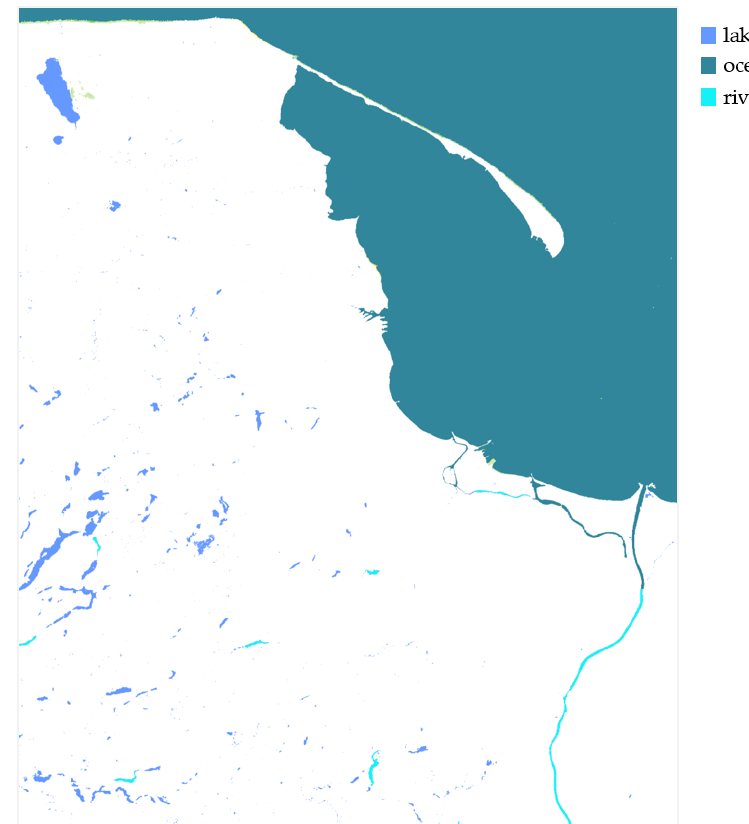
Figure 5. Example of the classification around Gdansk, Poland with the ocean Baltic Sea in petrol, the lakes, e.g., of the Pomeranian Lakeland in blue and the river Vistula in